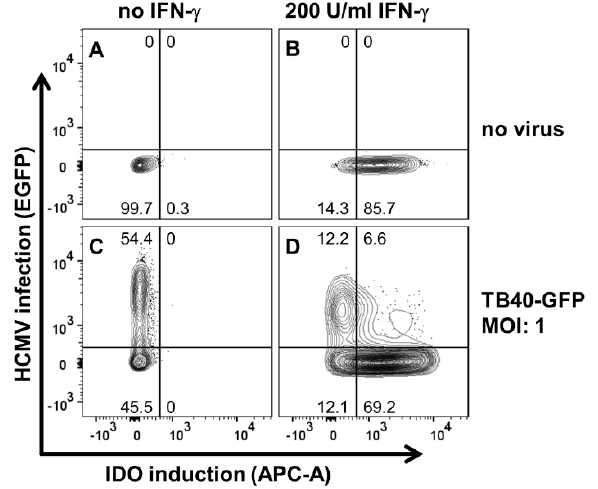
Figure 1. Human cytomegalovirus (hCMV) controls induction of interferon-gamma (IFN- γ ) dependent indoleamine 2,3-dioxygenase-1 (IDO) expression. Human retinal pigment epithelial (RPE) cells were either left untreated ( A ) or reated with 200 U/mL IFN- γ ( B ). TB40-GFP (m.o.i. of 1) was used to infect untreated ( C ) or IFN- γ -treated hRPE cells ( D ). Cells were harvested 24 h after infection and/or IFN- γ treatment and stained for expression of IDO1. Enhanced green fluorescent protein (EGFP) expression was used as an infection marker. The numbers in the panels indicate the proportion of IDO1-expressing and/or hCMV-infected cells (% of total population).